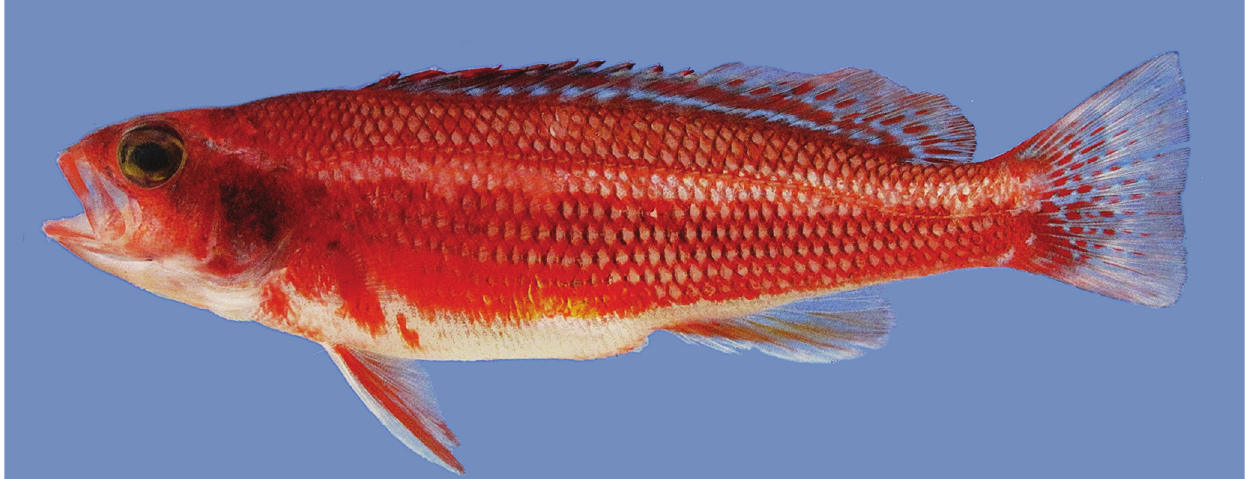
Fig. 1. Serranus aliceae , holotype, Brazil, Rio de Janeiro, Arraial do Cabo, Ilha de Cabo Frio, Saco dos Ingleses, MNRJ 38911, 67.1 mm SL, just after collection. Photo by Osmar J.